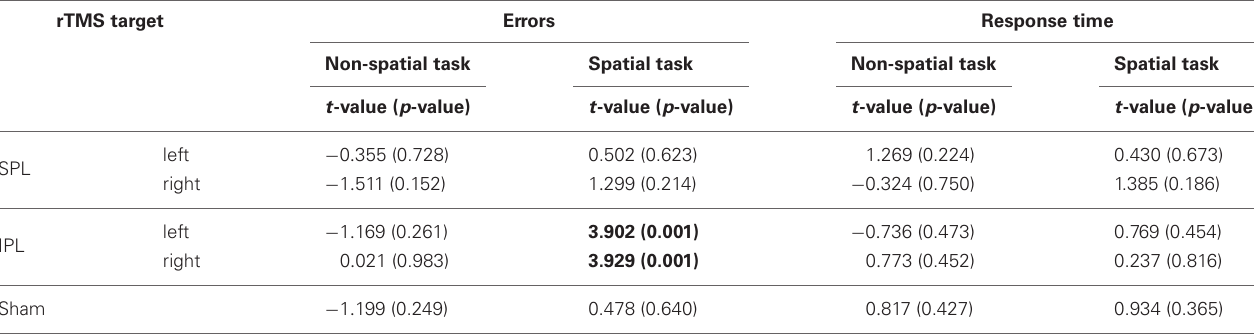
Table 1 | Statistical analysis of errors and response time in the spatial and non-spatial tasks. rTMS